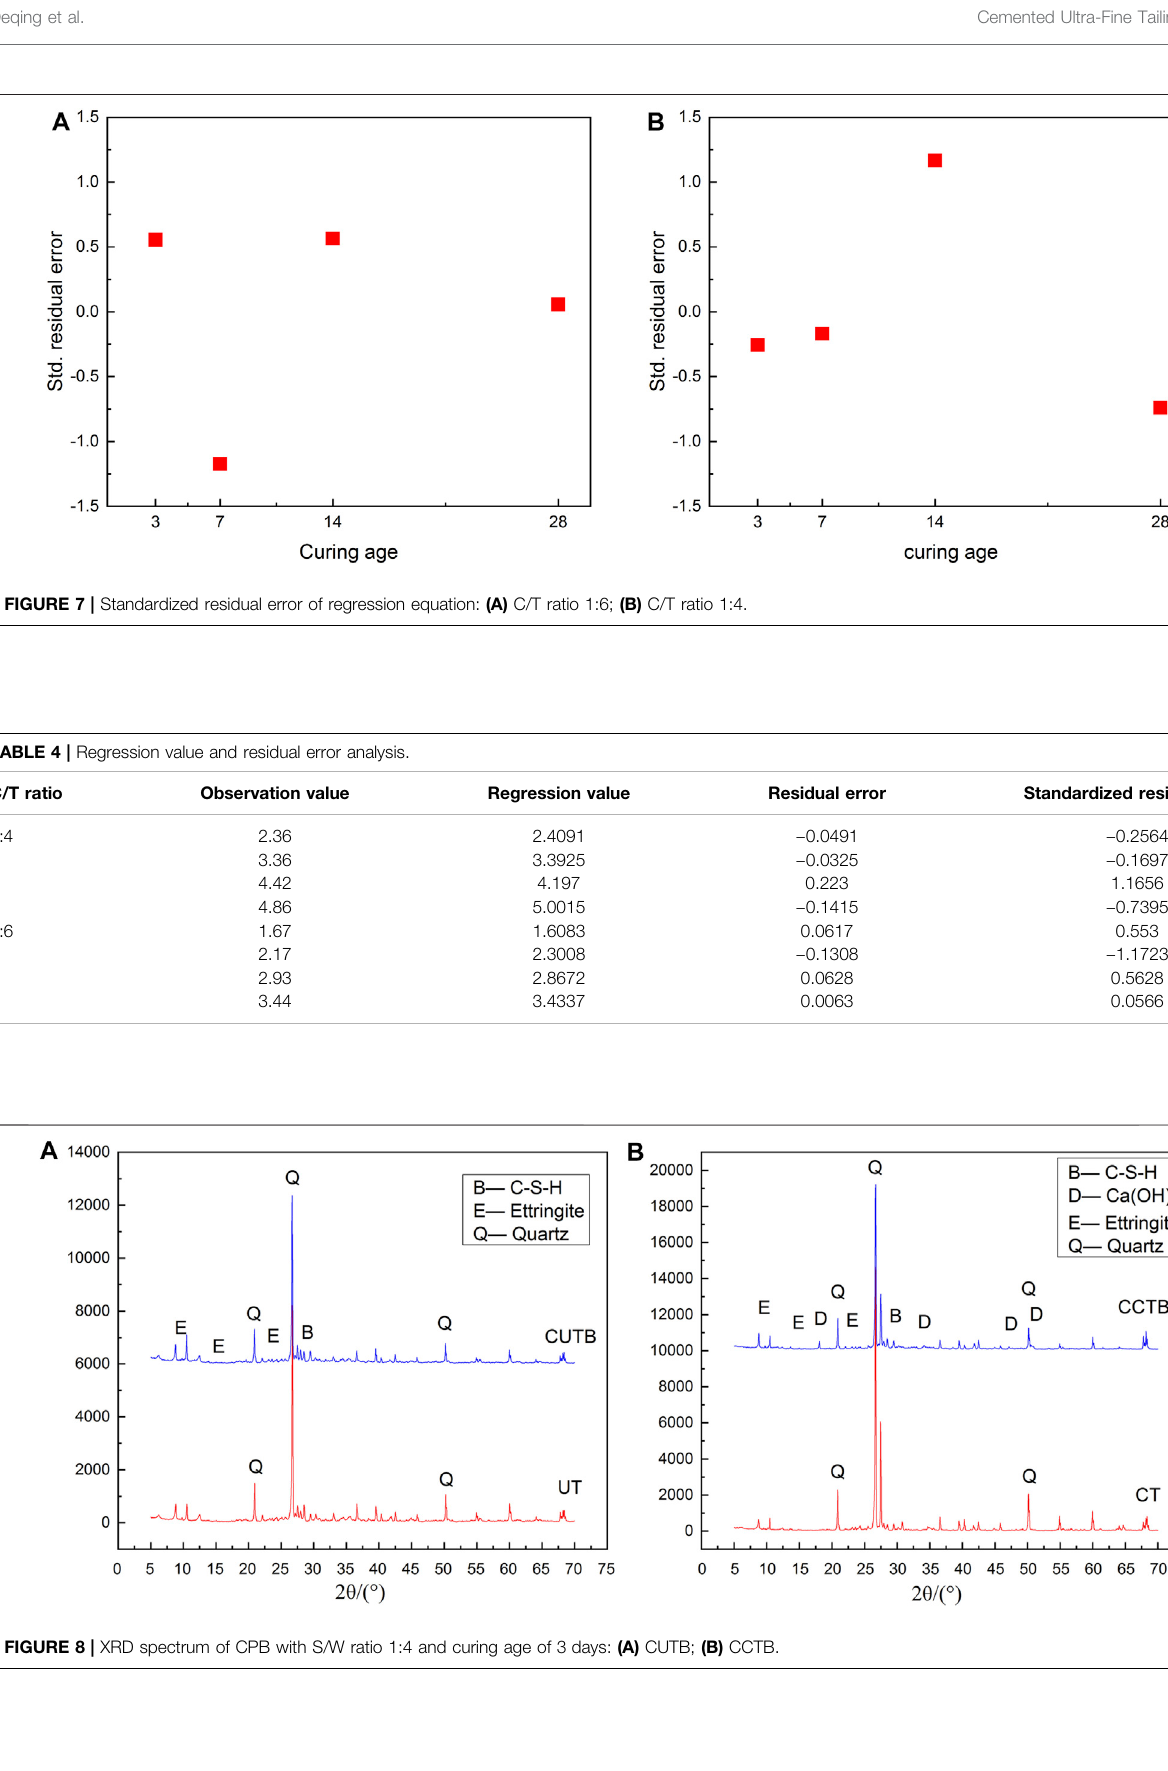
Frontiers in Materials |